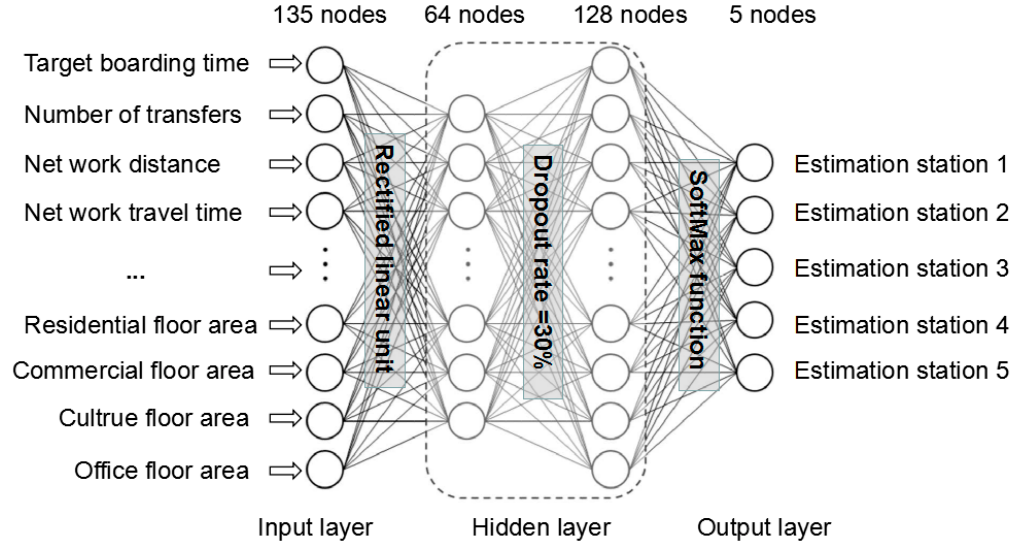
Figure 2. Overall structure of deep learning model.